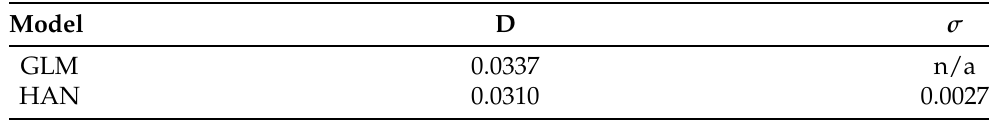
Table 5. Poisson divergence for model